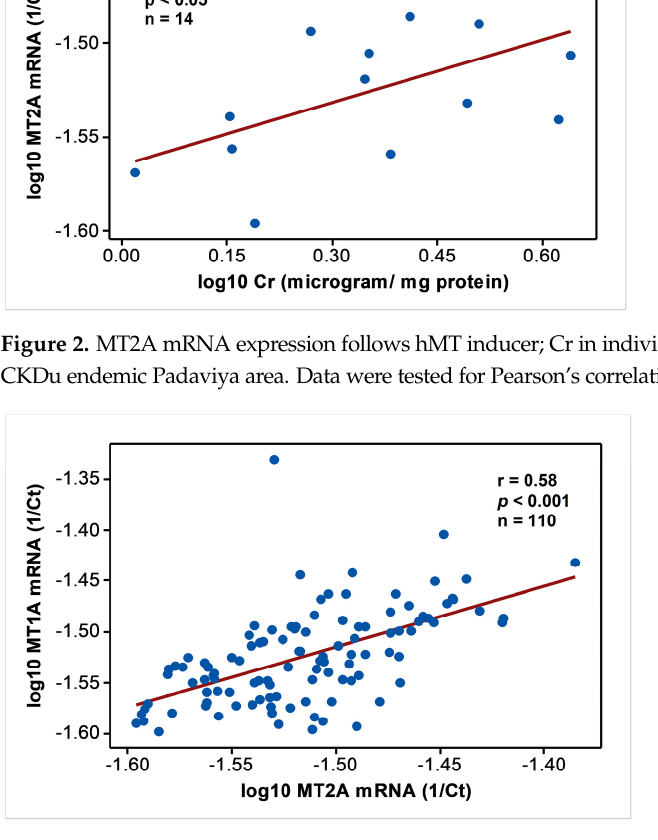
Figure 3. Comparable expression of MT1A and MT2A mRNA in the study. Data from endemic control, nonendemic control, and CKD stages G1–G5 were tested for Pearson’s correlation and shown in linear scale axes.